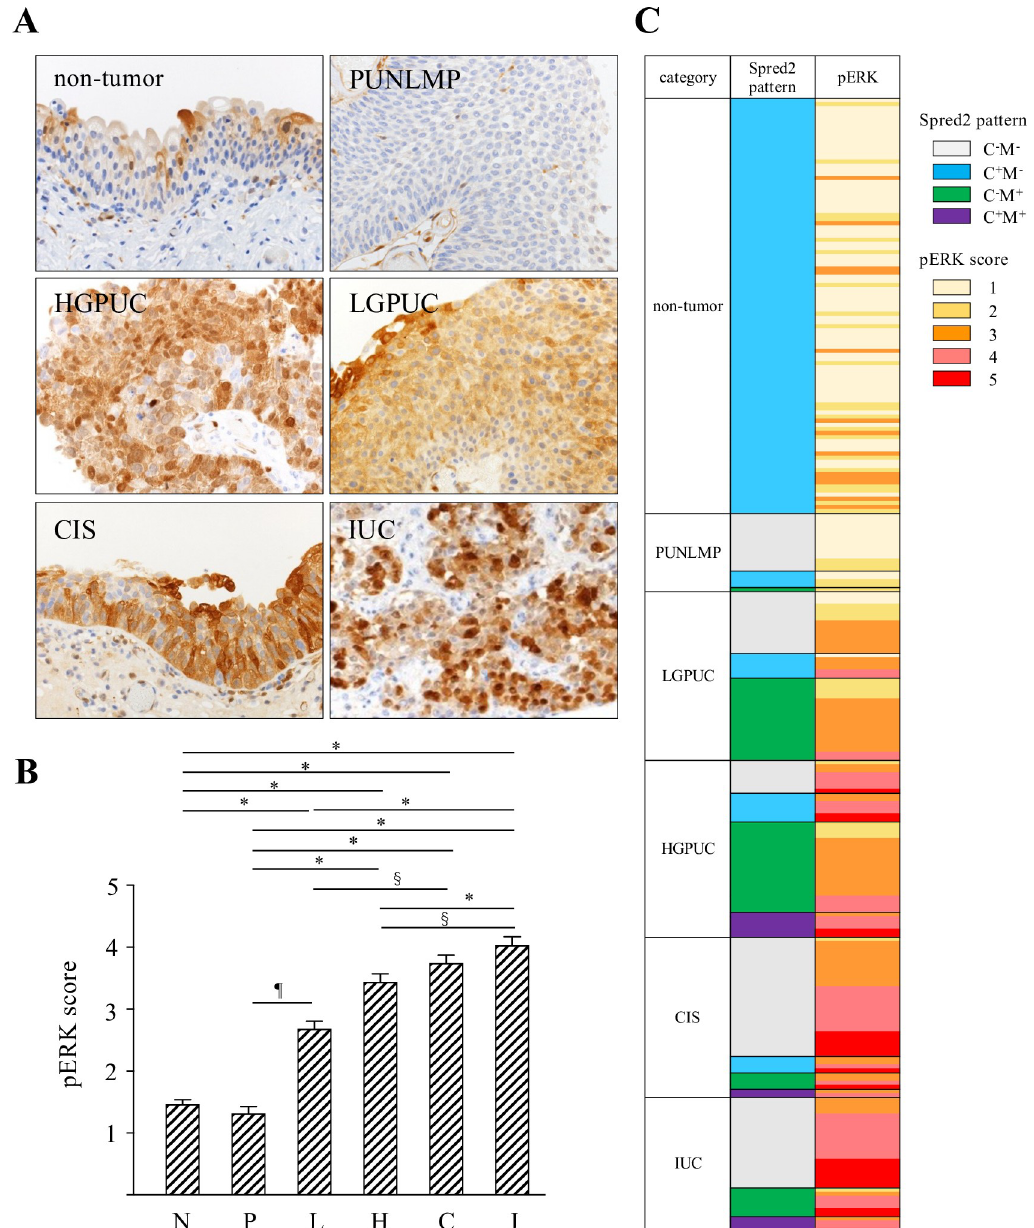
Fig 3. pERK score in urothelial tumors. (A) Representative photographs of pERK immunohistochemistry (original magnification 400 × ) from each category are shown. (B) pERK staining intensity was evaluated and scored (0–5), and pERK score in each category was shown (N: non-tumor; n = 101, P: PUNLMP; n = 19, L: LGPUC; n = 41, H: HGPUC; n = 43, C: CIS; n = 39, and I: IUC; n = 32). Data were mean ± SEM. § p < 0.01, ¶ p < 0.001, � p < 0.0001 (Dunn’s multiple comparison